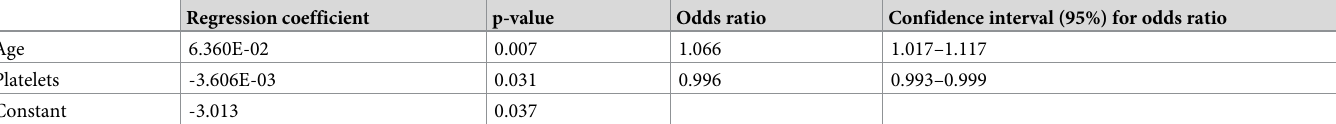
Table 2. Regression coefficients, significance, and odds ratio with confidence interval for the regression model calculated with the parameters age and initial plate- lets count (platelets). Regression